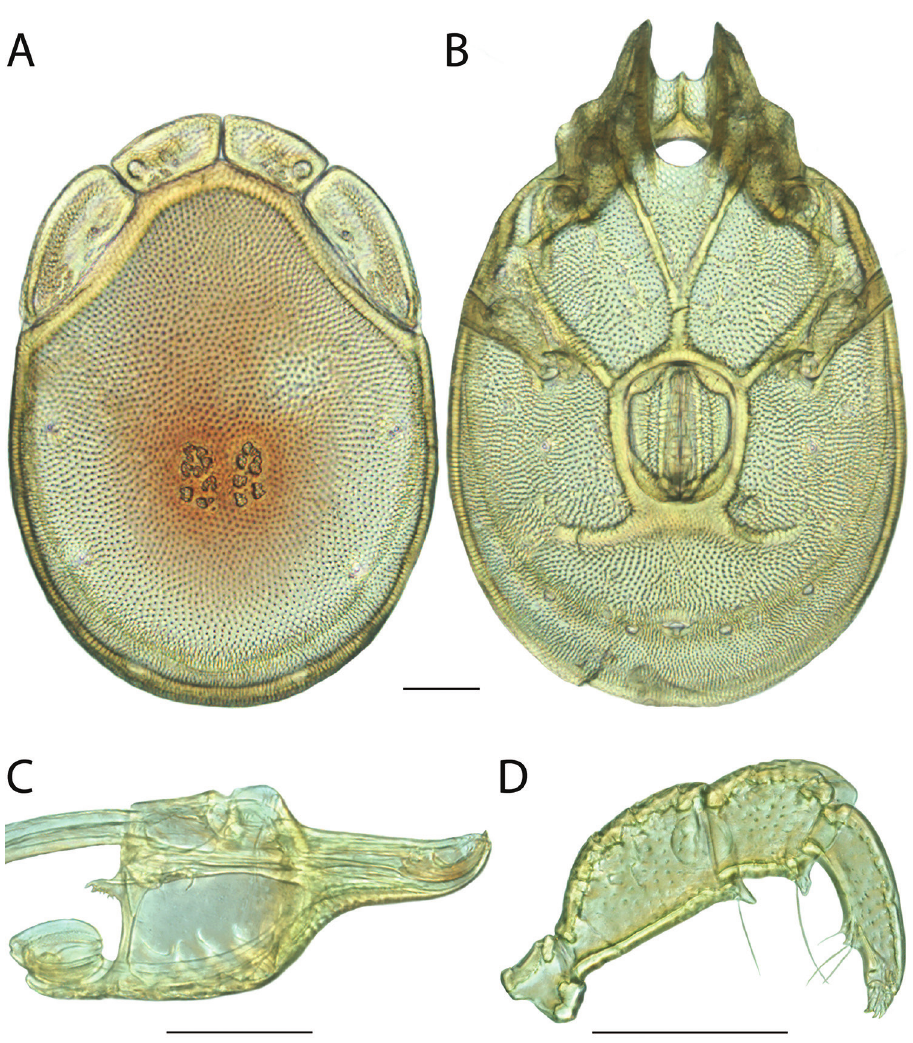
Figure 160. Torrenticola multiforma male: A dorsal plates B venter (legs removed) C subcapitulum D pedipalp (setae not accurately depicted). Scale = 100